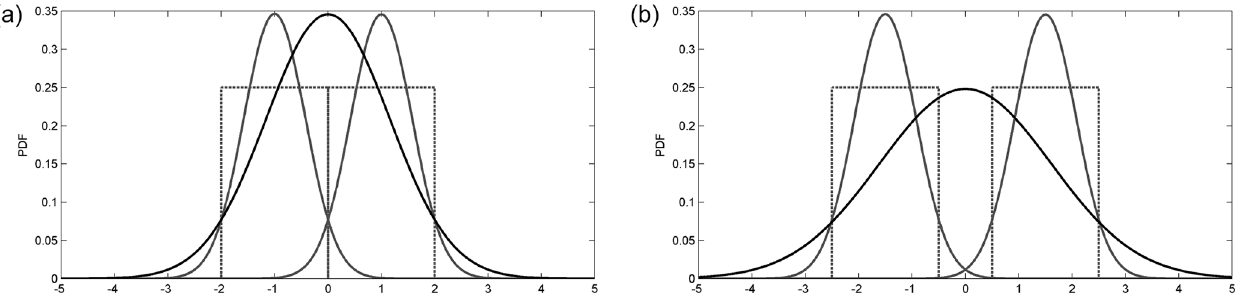
Figure 7. Two uniform distributions (dotted gray lines), their Gaussian approximations (solid gray lines) and the Gaussian resulting from their merger (solid black line). Notice that the joint Gaussian has higher densities at the tails compared to its